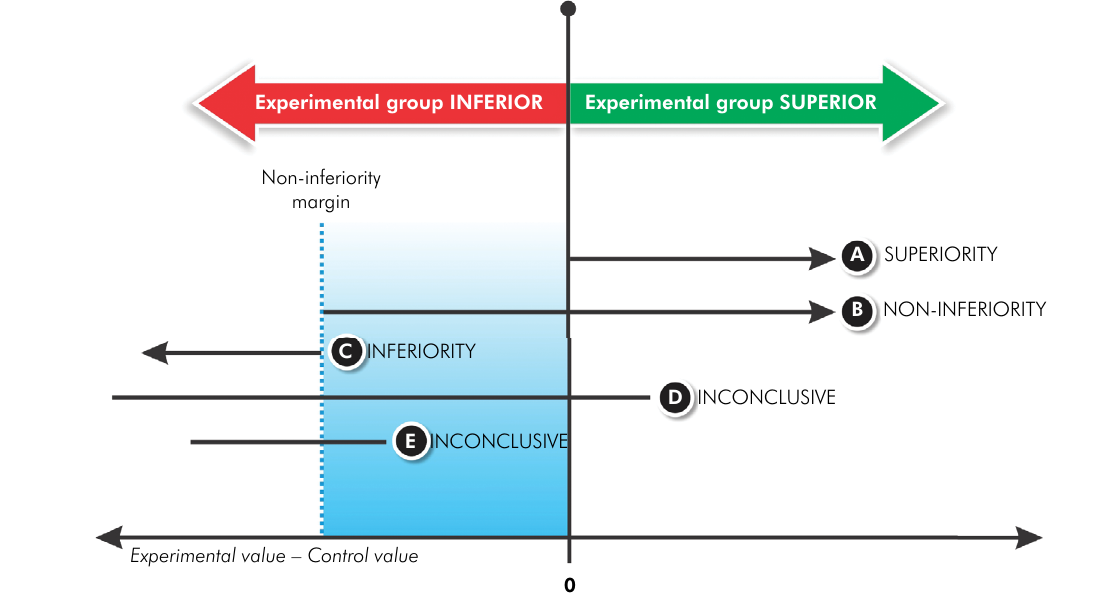
Figure. Non-inferiority margin and the relationship with 95% confidence interval of the difference between experimental and control